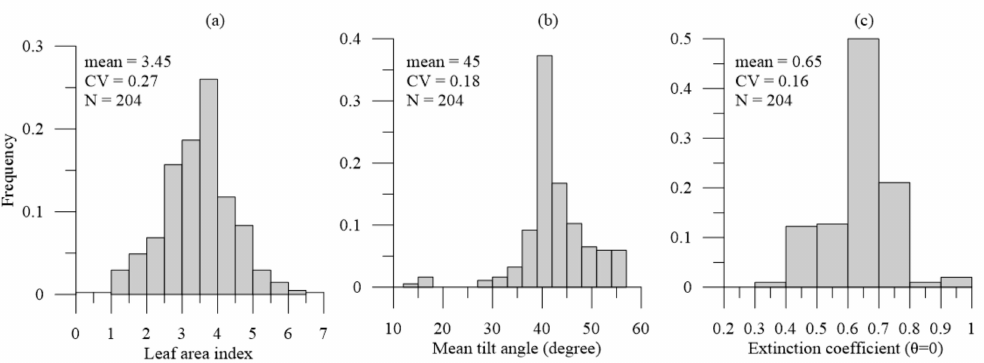
Figure 5. Distribution of the leaf area index ( a ), mean tilt angle ( b ) from LAI-2000 measurement. The extinction coe ffi cient at zenith angle = 0 ◦ is plotted in panel ( c ).